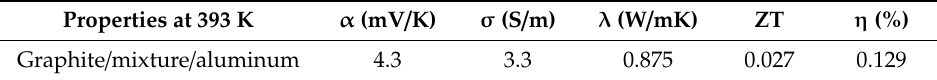
Table 1. Parameters of the thermoelectric generator at 393 K.